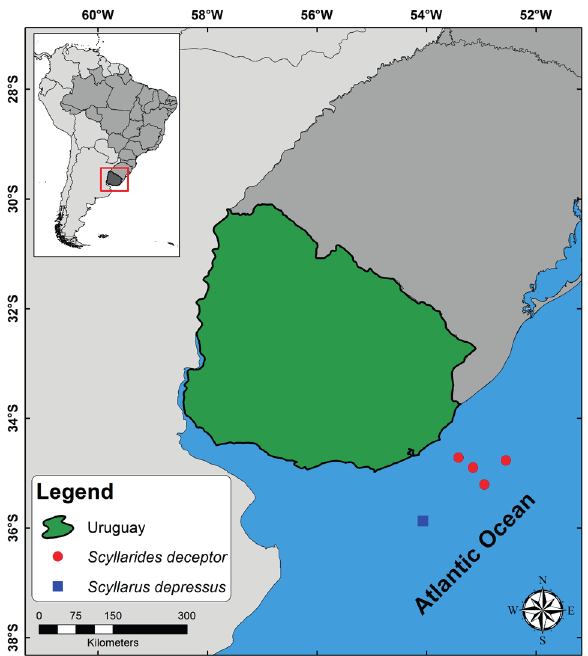
Figure 1. Distribution of Scyllaridae species sampled in Uruguayan